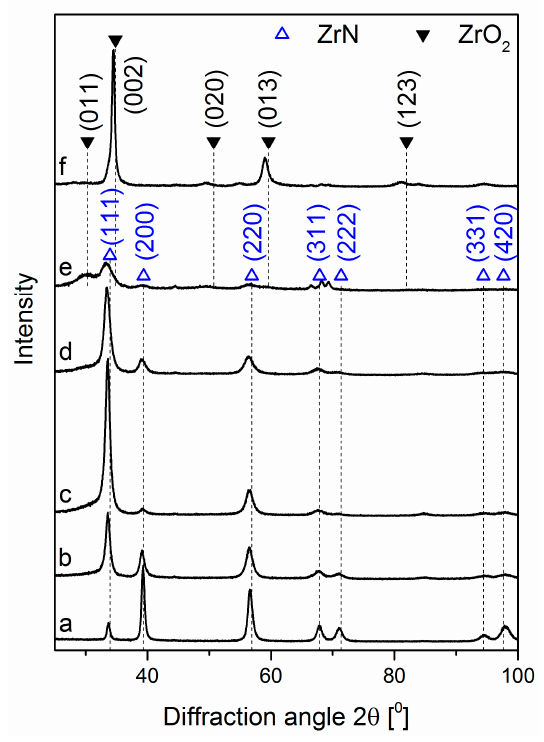
Figure 7. XRD patterns of ZrON coatings synthesized at various relative oxygen concentration O 2(x) , ( a ) 0%, ( b ) 10%, ( c ) 20%, ( d ) 30%, ( e ) 50%, ( f ) 100%.